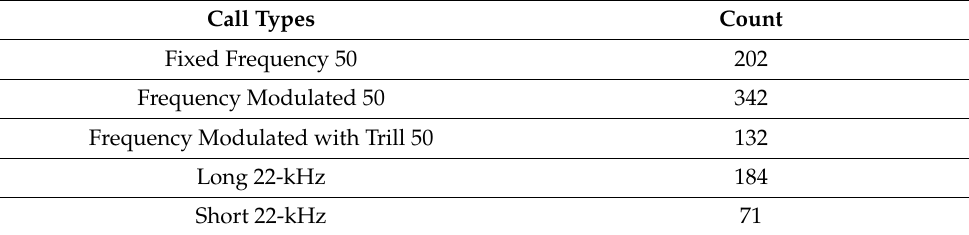
Table 3. Number of each of five call types in the five-call composite dataset classified by an ex- pert scorer.